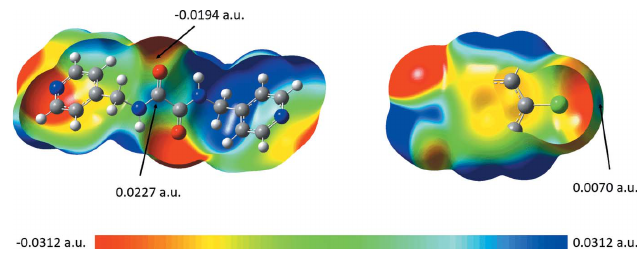
Figure 6 The electrostatic potential surface mapping for 4 L H 2 and CBA as obtained from Gaussian 16 , showing the average ESP charge on the surface of the point of contact for the Cl1/Cl2, C7/C14 and O1/O2 interactions. The electrostatic potential was mapped onto the isodensity surface (0.0004 a.u.) within the scale of (cid:4) 0.0312 to 0.0312